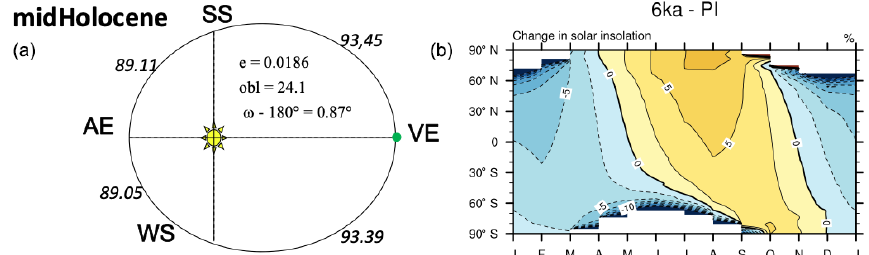
Figure 14. (a) Orbital configuration for the midHolocene (6ka) experiment. (b) Latitude–month insolation anomalies 6ka–1850 as percent- age change from PI.